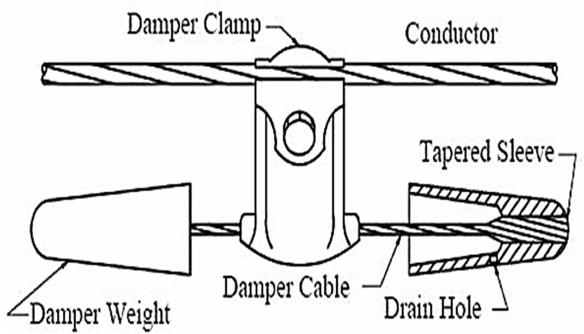
Figure 1: Spiral vibration damper